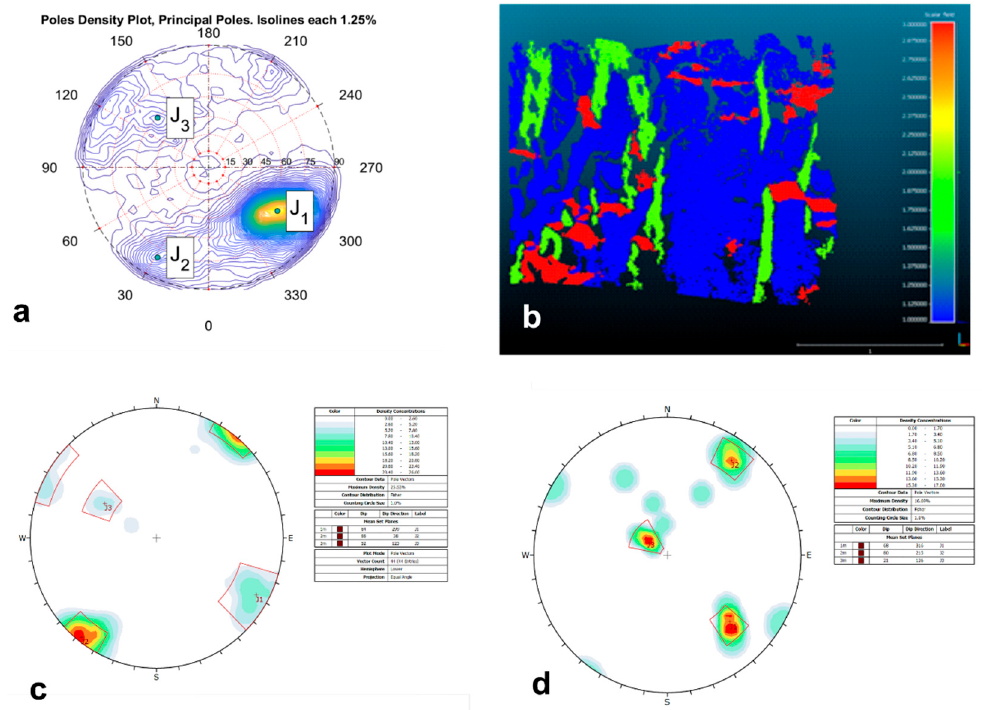
Figure 5. ( a ) Stereonet of the density of the normal vector’s poles and its corresponding planes based on Discontinuity Set Extractor (DSE); ( b ) discontinuity sets at site 1, colored as blue ( 𝐽 1 ), green ( 𝐽 2 ) and red ( 𝐽 3 ); ( c ) Stereographic projection of concentration lines of discontinuity poles from CloudCompare™ approach; ( d ) Stereographic projection of concentration lines of discontinuity poles